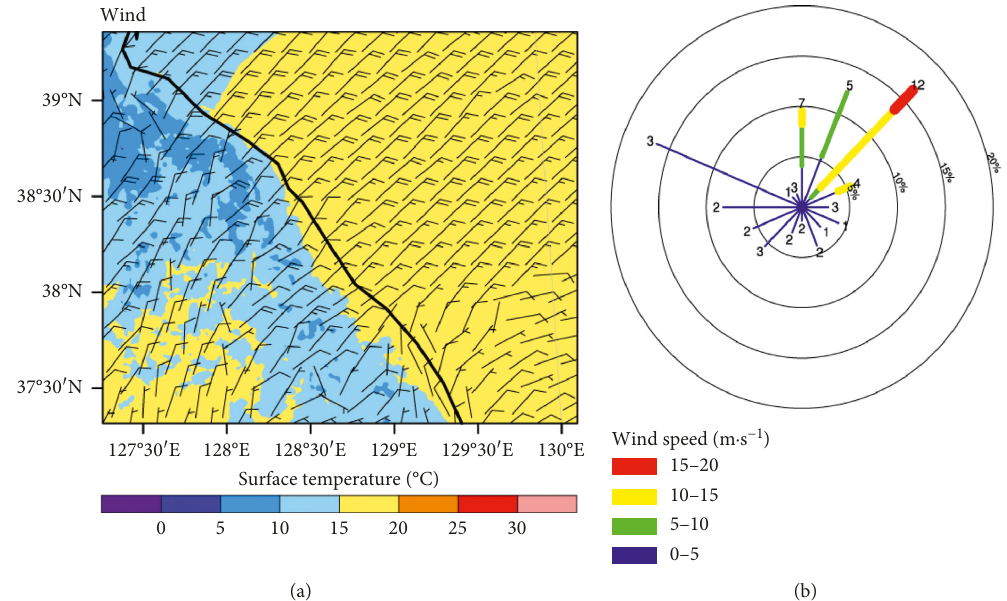
Figure 10: Simulated wind vector and surface temperature fields in the innermost WRF model domain at 24:00 UTC on October 22, 2006 (a), and wind rose diagram for the strong wind event observed at the Daegwallyeong ASOS